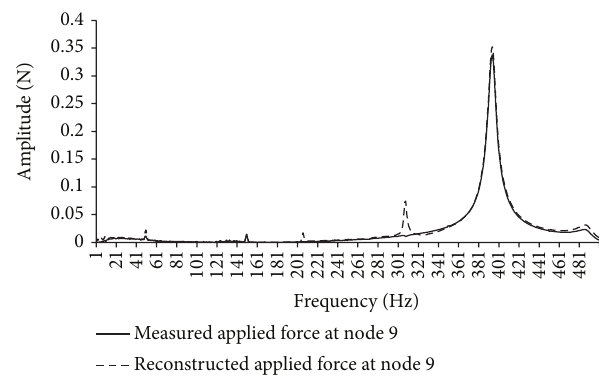
Figure 17: Experimental and reconstructed applied load 𝐹 9